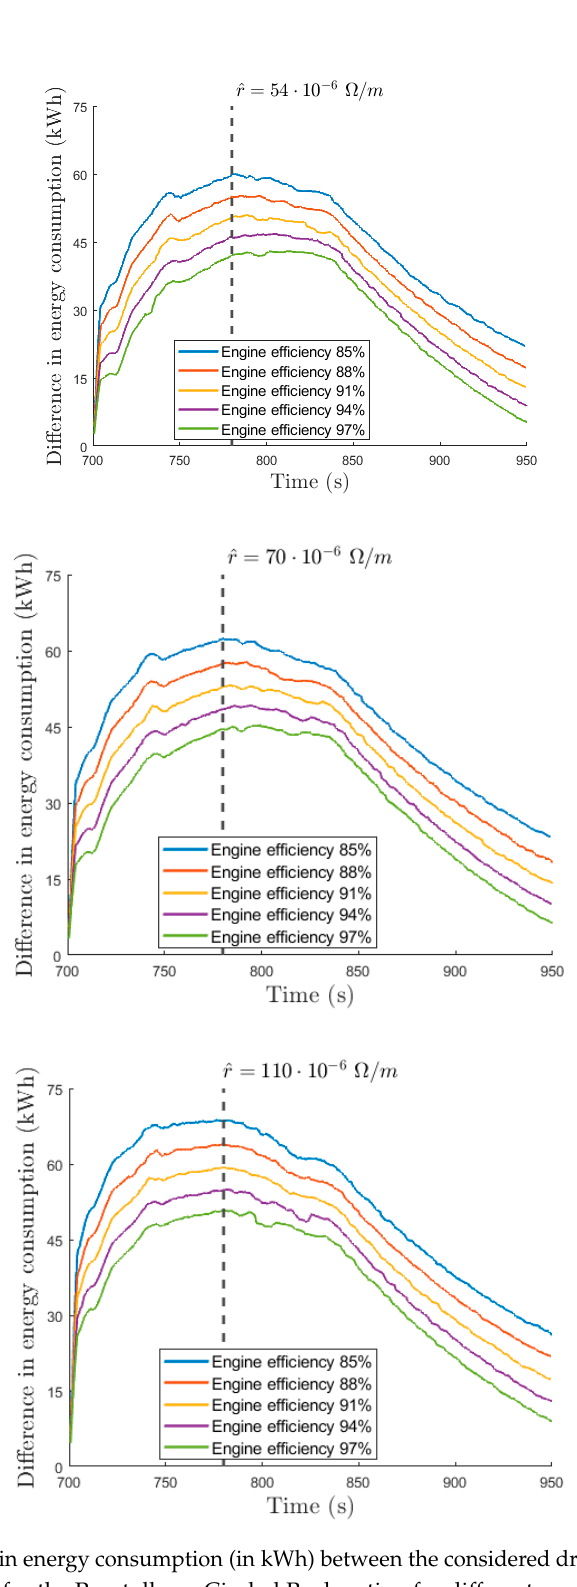
Figure 13. Difference in energy consumption (in kWh) between the considered driving strategies at the electrical substations for the Puertollano–Ciudad Real section for different running times. Different values of the catenary linear resistance 𝑟̂ and different values of the engine efficiency are considered.